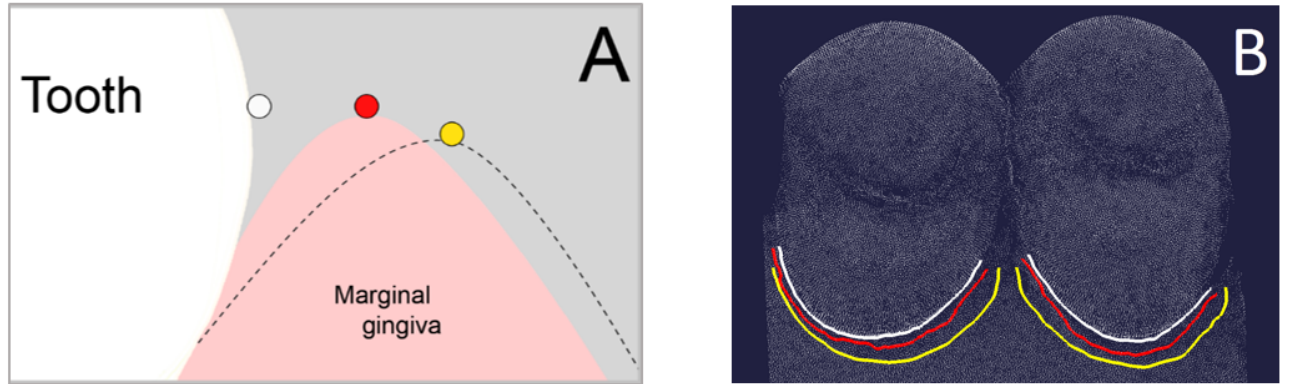
Figure 5. ( A ) Position of base curve (white dot), reference marginal curve (red dot) and intervention marginal curve after gingival displacement (yellow dot). Schematic view in cross section. ( B ) Base curve (white), reference marginal curve (red) and intervention marginal curve (yellow) on both premolars after aligning the datasets of unexposed reference and intervention model.